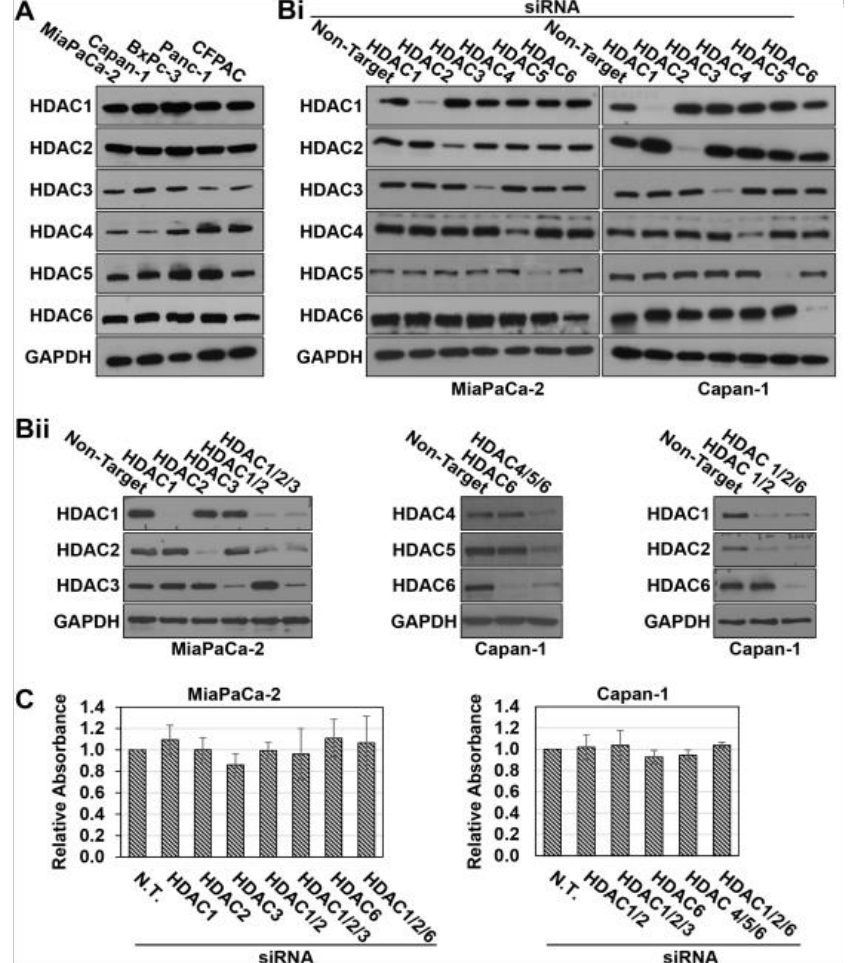
Figure 2. Knockdown of pan-histone deacetylase (HDACs) 1–6 in PDAC cells. ( A , B ) Western blot analysis of HDAC1, 2, 3, 4, 5, and 6 expression in the indicated cell lines. Cells were either untransfected ( A ) or transfected with non-targeting small interfering (si)RNA or ONTARGET plus SMARTPool siRNAs (each including four di ff erent siRNAs) targeting the indicated HDACs 48 h prior to harvest ( Bi , ii ). ( C ) MiaPaCa-2 and Capan-1 cells were transfected with the indicated siRNAs, and cell viability was determined by MTT assay 48 h after transfection. Data are representative ( A , B ) or means ± s.e. ( C ) of at least three independent experiments.